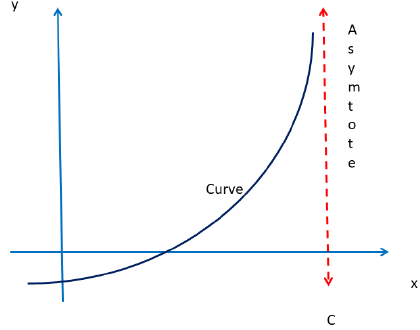
Figure 1. Vertical asymptote as in the following source: [37].